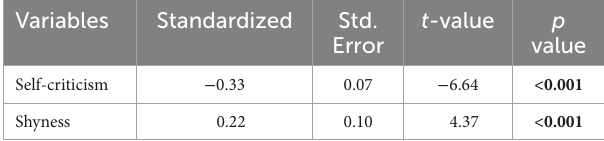
TABLE 7 Linear regressions and p value for the impact of self-criticism when experiencing difficult emotions, and shyness on psychological well-being.